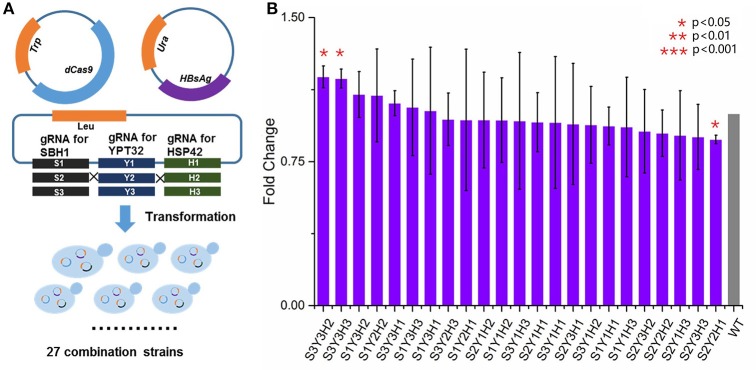
The impact of multiplex repression of SBH1, HSP42, and YPT32 on HBsAg expression. (A) The schematic design of multiplex repression of genes by dCas9-based CRISPR system. (B) The effects of multiplex gene repression on HBsAg expression. Each data point represented the mean of biological triplicates and the fluorescence was normalized by OD600. The error bars corresponded to standard deviation. Student's t-test was used to calculate the p-values and we considered two samples were statistically different if p < 0.05. The p < 0.001 was marked with three asterisks; p < 0.01 was marked with two asterisks; and p < 0.05 was marked with one asterisk. No significant difference between the test strains and the control strain was found in this study. The details of each strain were shown in Table S2.